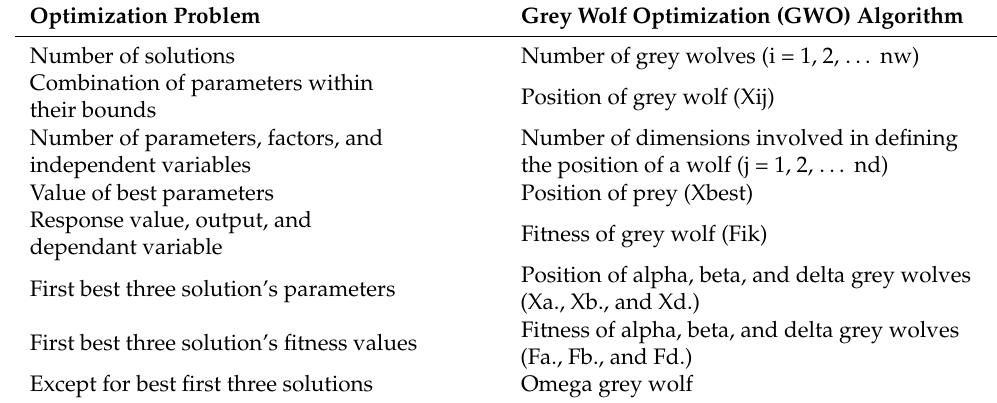
Table 10. Terms in GWO and optimization problems.